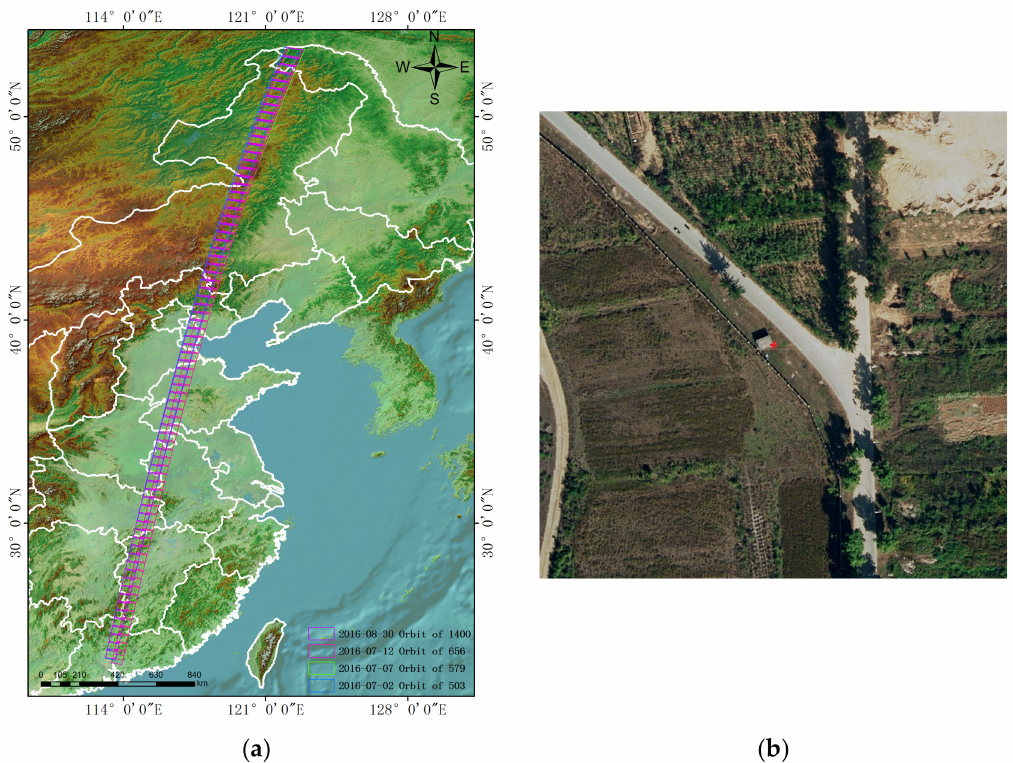
Figure 7. ( a ) The coverage for four strips of data in China. ( b ) Schematic diagram of corresponding 1:5000 control points obtained via photographs taken in aerial photography field work; these points were used to assess the direct geolocation accuracy of the four strips of